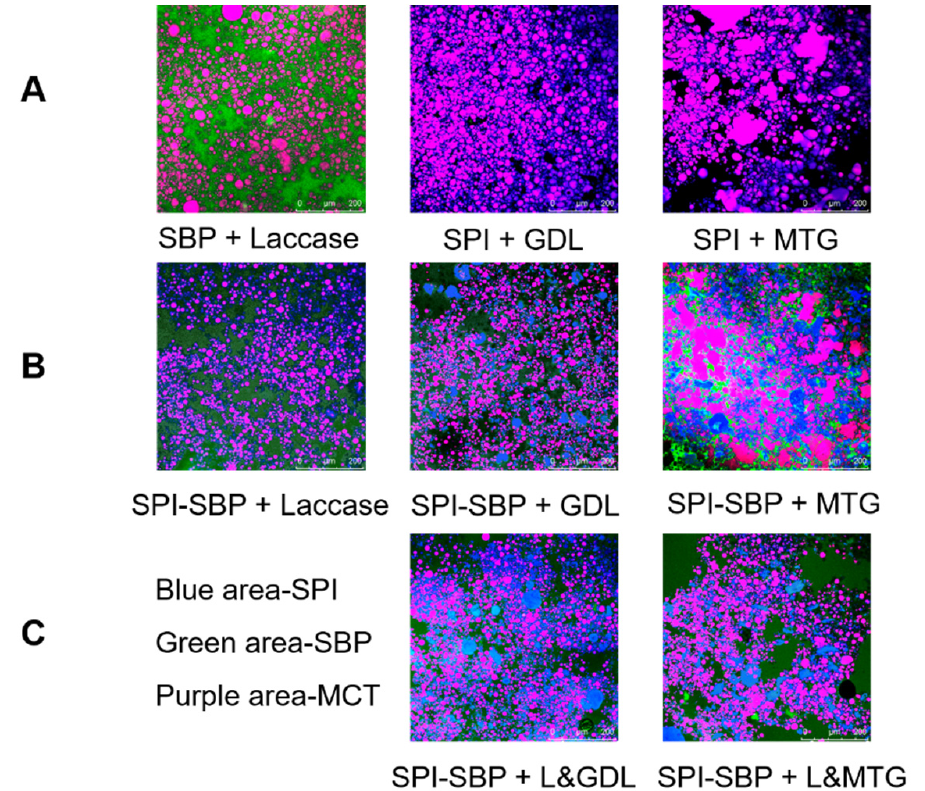
Figure 4. The CLSM micrographs of SPI or SBP emulsion gel induced by single method ( A ), SPI-SBP emulsion gel induced by single method ( B ), and SPI-SBP emulsion gel induced by double methods ( C ). The scale bar indicates 200 µ M. SBP was labeled by FITC for green. SPI was stained by Rhodamine B for blue. MCT was stained by Nile Red for red.